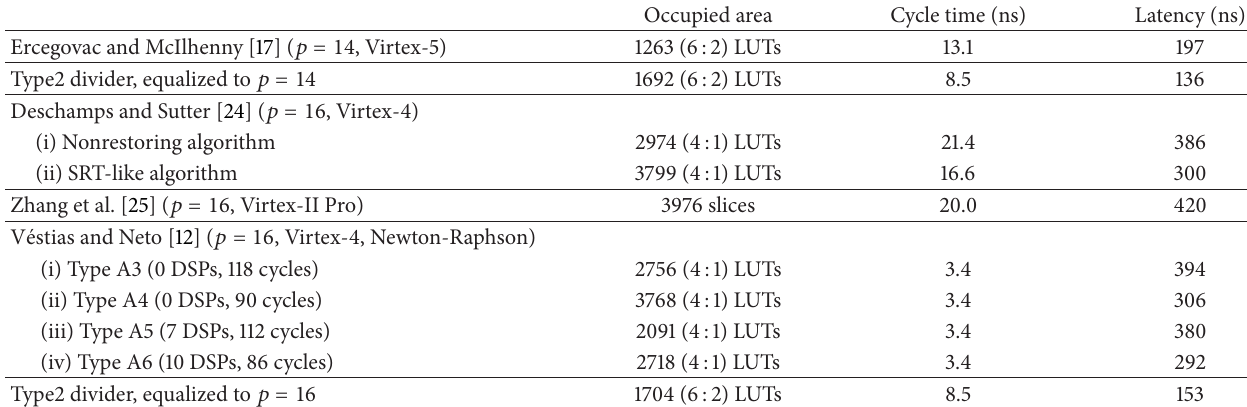
Table 5: Performance comparison of fixed-point